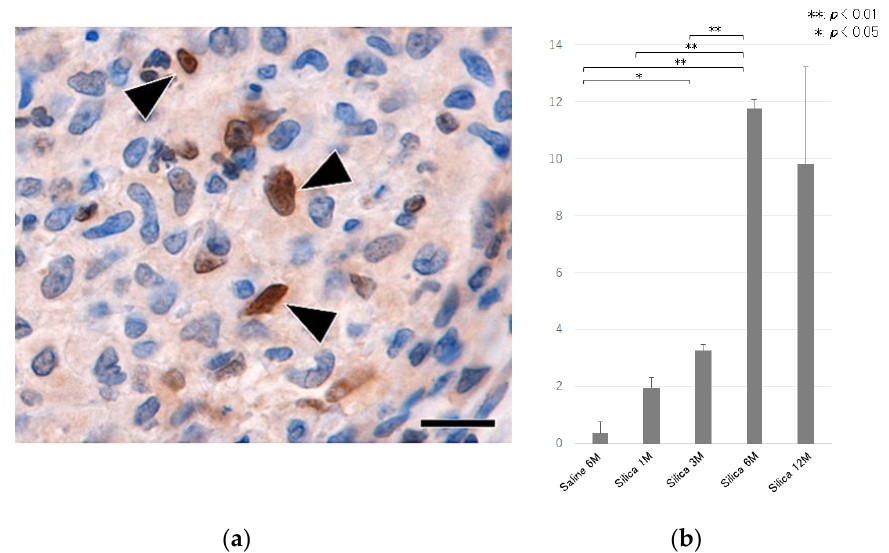
Figure 5. ( a ) Microscopic findings of the fibrotic lesion of the lung tissue at 6 months after silica treatment, showing positive labeling for Ki-67 in spindle cells (black arrow heads) in the fibrotic lesions. Ki-67 immunohistochemistry. Bar = 15 µ m, and ( b ) semiquantitative analysis of the immunohistochemical reactions of Ki-67 in the lung tissues. An increase in the number of Ki-67 positive cells are shown in the treated lungs. All data are expressed as mean ± SD. Statistically significant differences (* p < 0.05, ** p < 0.01) are indicated.